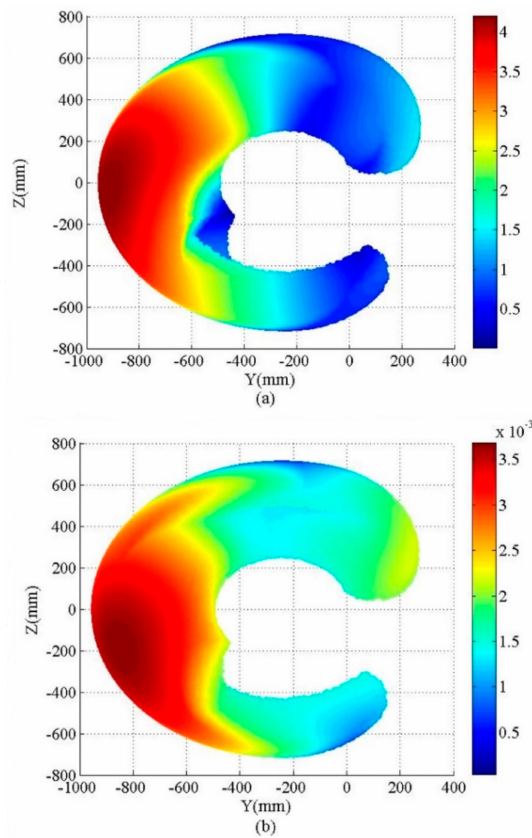
Figure 5. The error between the nominal pose and the actual pose of R2. The unit of position error in ( a ) is mm. The unit of orientation error in ( b ) is